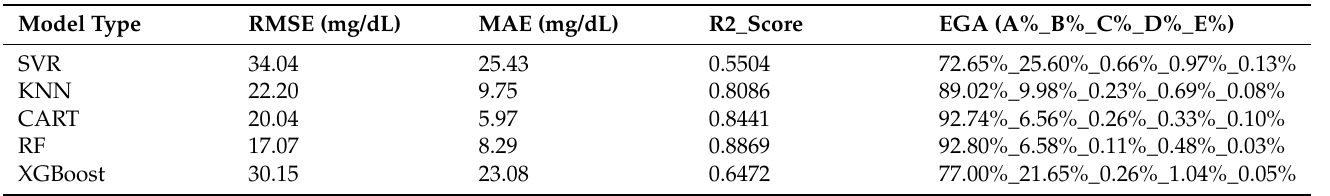
Table 3. The prediction accuracy of five machine learning